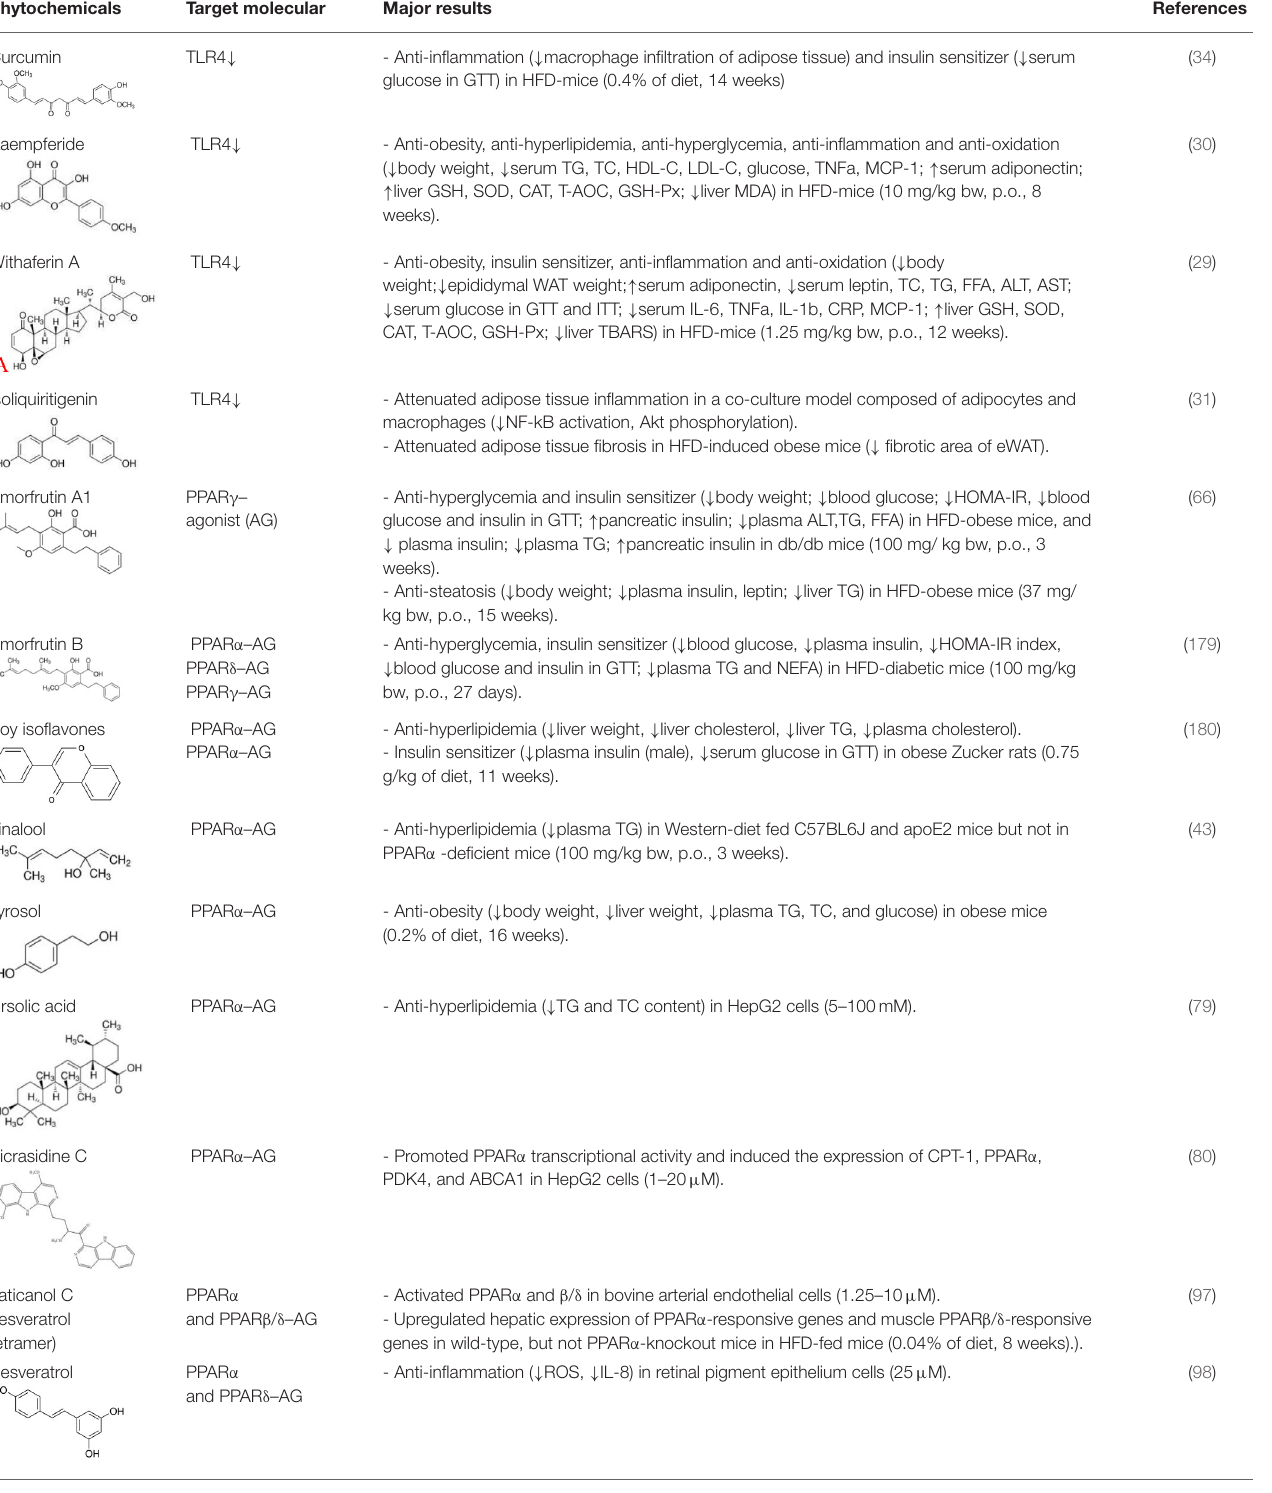
TABLE 1 | Phytochemicals targeting specific signaling pathway act against obesity and related symptoms.